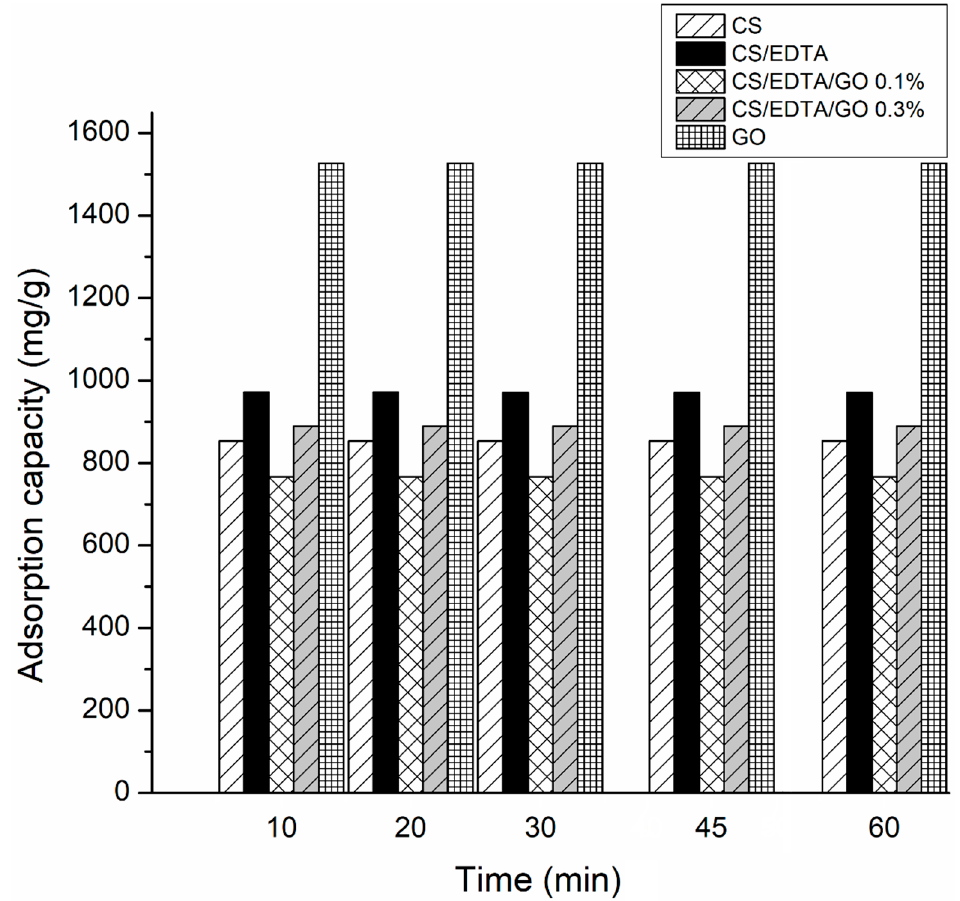
Figure 7. Sorption capacity of the membranes CS, CS/EDTA, CS/EDTA/GO 0.1%, CS/EDTA/GO 0.3% and GO sheets. * Standard Deviation (SD) = 1–3%.